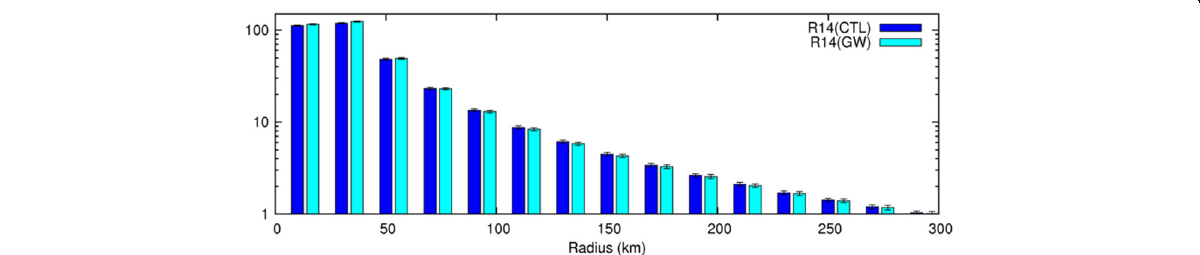
Fig. 11 Size distribution of high clouds showing its changes between present and future climate simulations. Size distribution of high clouds in present ( dark blue ) and future ( light blue ) climate simulations using the NICAM AMIP-type simulation are analyzed by following the method described by Noda et al. (2014). Standard variations are designated at each